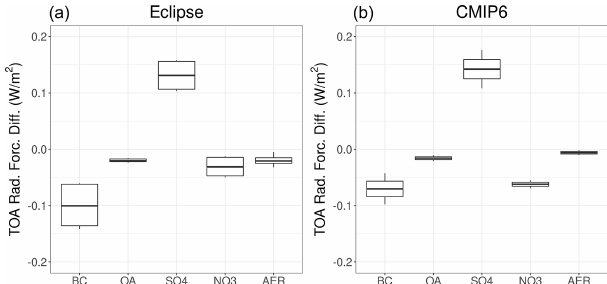
Figure 8. Box–whisker plot showing the differences between 1990– 2010 mean and 2030–2050 mean RF ARI for the anthropogenic aerosol components (BC, OA, SO 2 − , and NO − ) and their sum 4 3 (AER) in the Eclipse ensemble (CLE and MFR: a ) and the CMIP6 (SSP2-4.5 and SSP1-2.6: b ) ensembles. The boxes show the median and the 25th and 75th percentiles. The upper whisker is located at the lower range of the maximum value and Q_3 + 1 . 5IQR, whereas the lower whisker is located at the upper range of the smallest x value and Q_1 − 1 . 5IQR, where IQR (interquartile range) is the box height (75th percentile − 25th percentile).